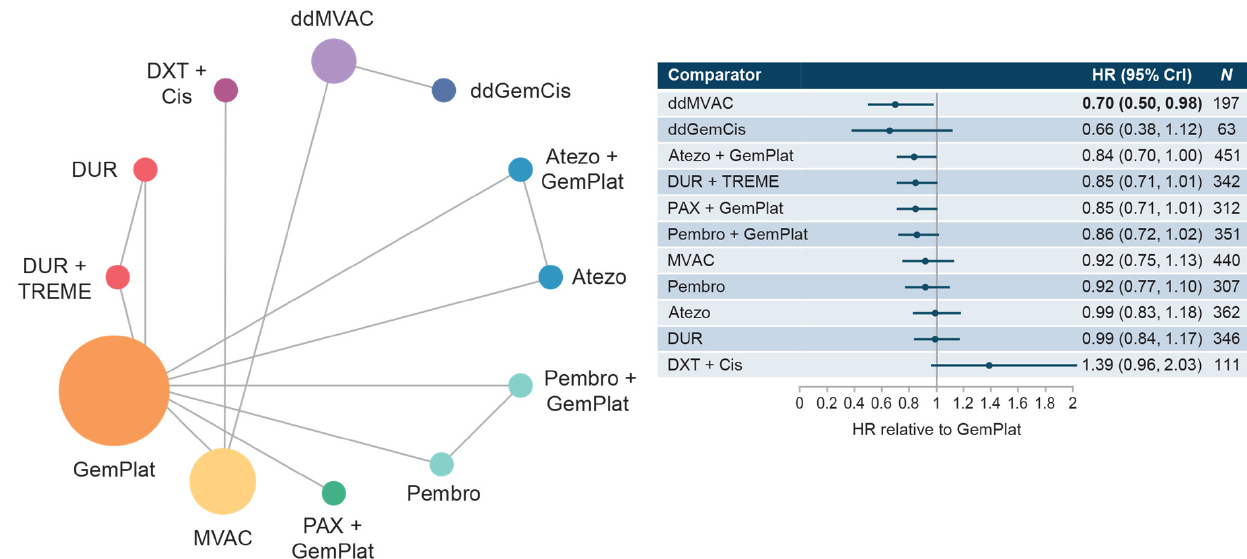
Figure 1. Network diagram and HR for OS by treatment network for the cis-eligible/mixed network.